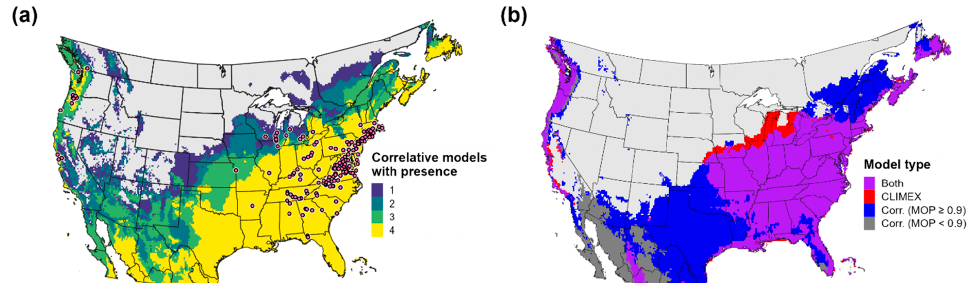
Figure 6. Estimates of the potential distribution for Calonectria pseudonaviculata in the contiguous United States and bordering areas in North America. A consensus map of ( a ) presence predictions produced by individual correlative models (probability of occurrence ≥ 0.3) depicts areas of high vs. low discordance and the approximate locations of all presence records for the region (pink circles). A consensus map of ( b ) all models shows overlap in the potential distribution according to the CLIMEX model (ecoclimatic index ≥ 10) and the ensemble correlative model (purple shading) compared to areas that were included in the potential distribution by only the CLIMEX model (red shading), or by the ensemble correlative model in areas with similar climates to the model calibration area (MOP values ≥ 0.9; blue shading). Correlative model predictions for areas that had dissimilar climates to the calibration area (MOP values < 0.9) and that were not included in CLIMEX’s estimate of the potential distribution (dark gray shading) were not